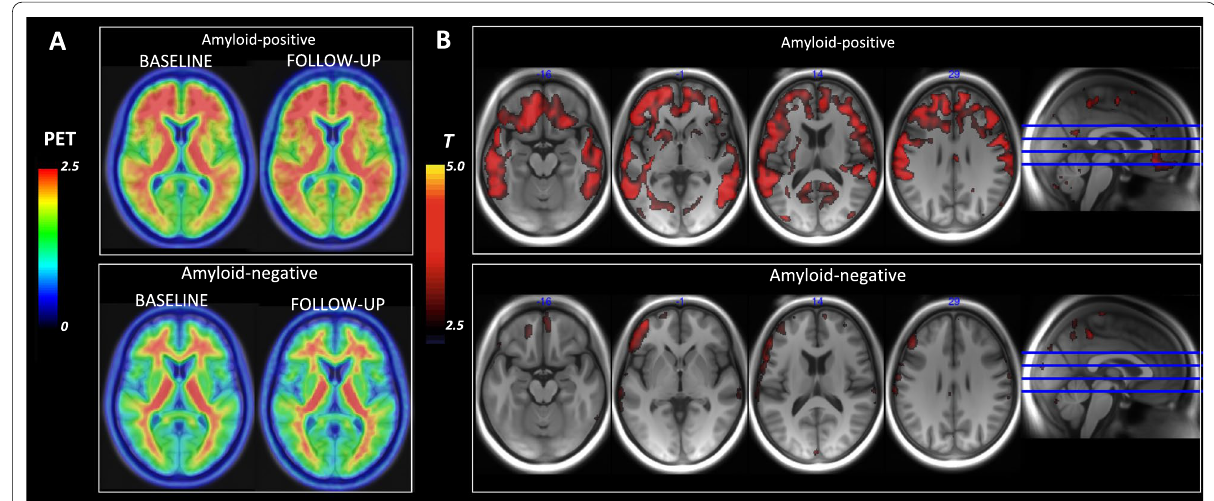
Fig. 1 A Average voxel-wise maps of baseline and follow-up. 18 F-Flutemetamol PET uptake ratios (warmer colors represent higher uptake ratios) in patients with amyloid-positive ( N 15/10) and amyloid-negative ( N 19/15) baseline scans. Patients with amyloid-positive baseline scans showed = = increased cortical 18F-Flutemetamol uptake. In contrast, in patients with amyloid-negative baseline scans, negligible 18F-Flutemetamol uptake was seen in gray matter at baseline or follow-up. B Voxel-wise statistical mapping was conducted to assess longitudinal change. Widespread clusters of positive change were observed in amyloid-positive (top panel), but not in amyloid-negative patients (bottom panel). Statistical parametric maps are